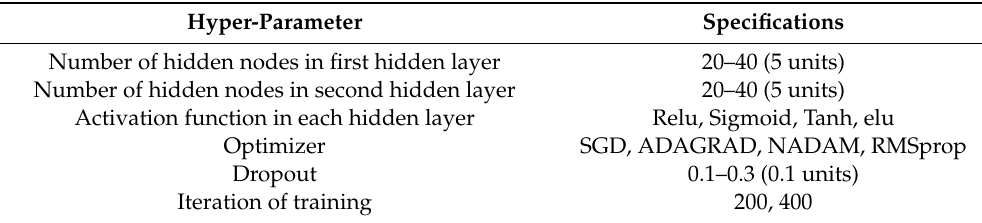
Table 2. List of Table 2. List of hyper-parameters.